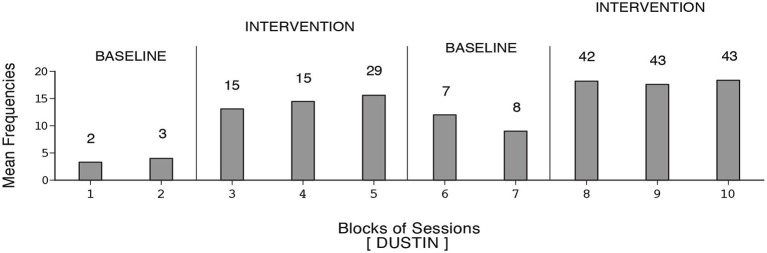
Dustin’s data plotted as in Figure 1.